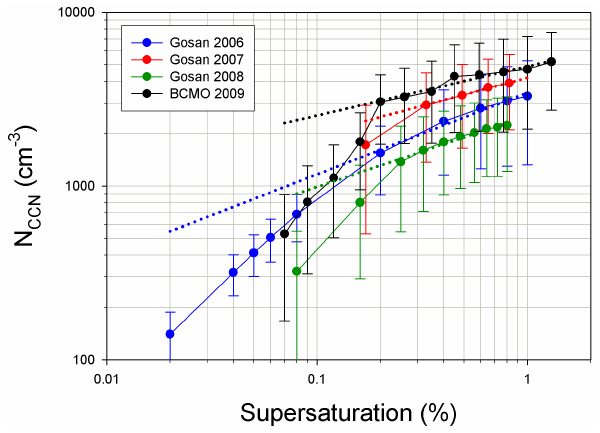
Fig. 5. Average CCN spectra (solid line) and power-law approxima- tion for S ≥ 0 . 2% (dotted line). The error bars represent standard deviations of N CCN